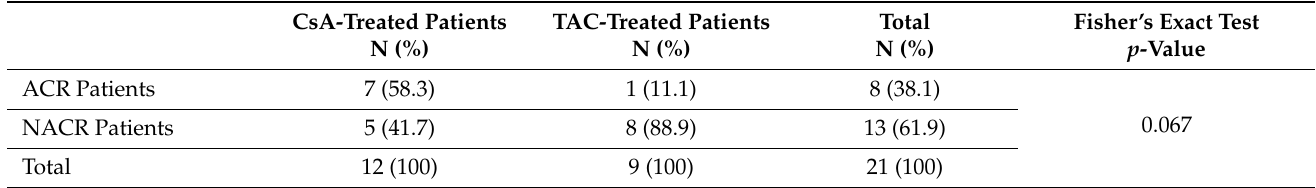
Table 3. The impact of cyclosporine and tacrolimus co-treatments in patients with and without acute cellular rejection (ACR).